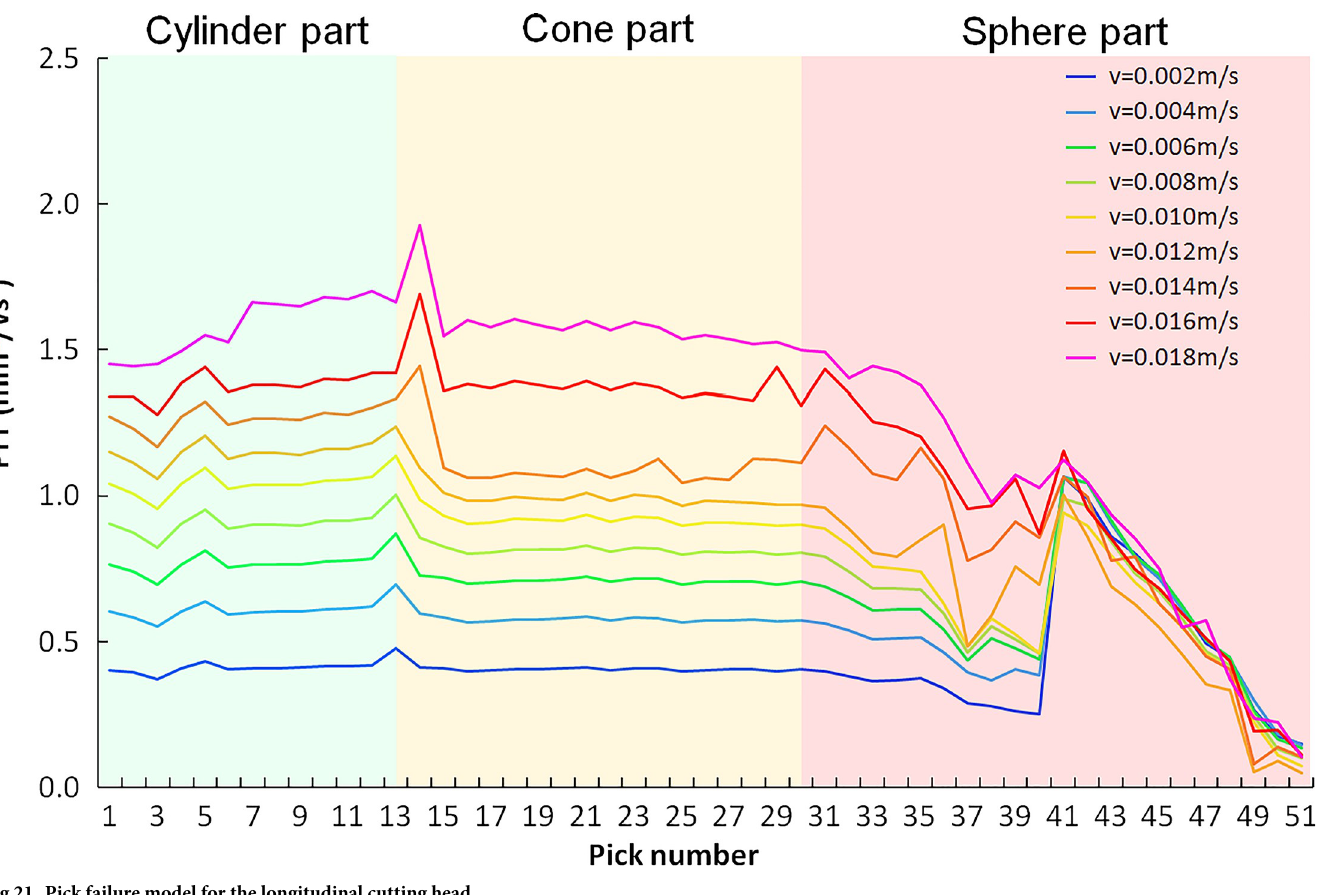
Fig 21. Pick failure model for the longitudinal cutting